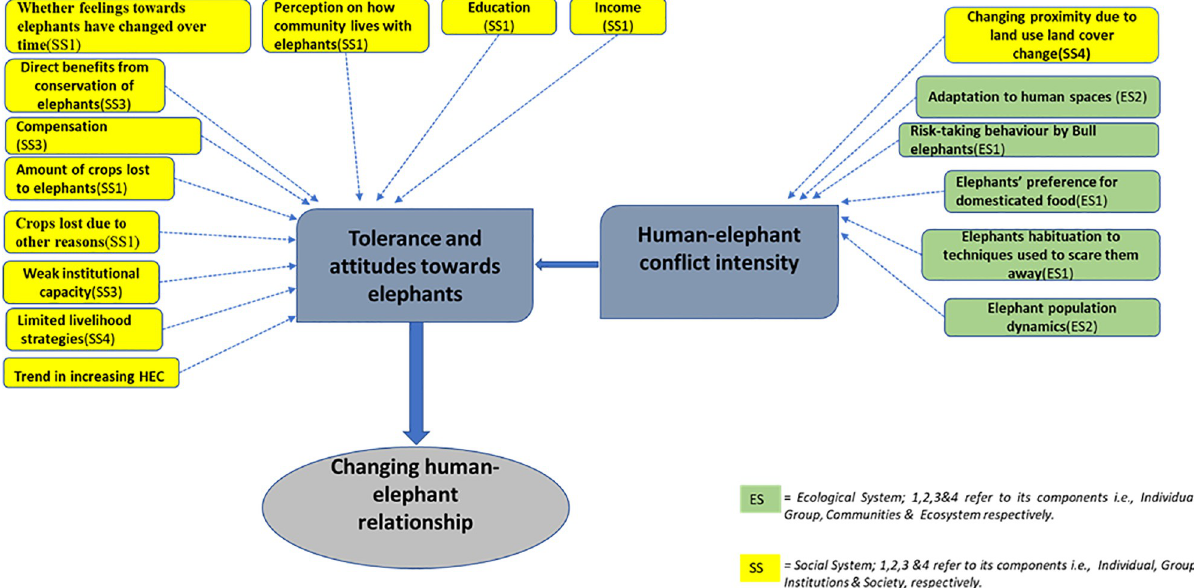
Fig 3. Social-ecological determinants of human-elephant relationship. SS = Social System and ES = Ecological System. SS and ES and their associated numbers correspond to SS and ES components in the Social Ecological System framework in Fig 1 above.